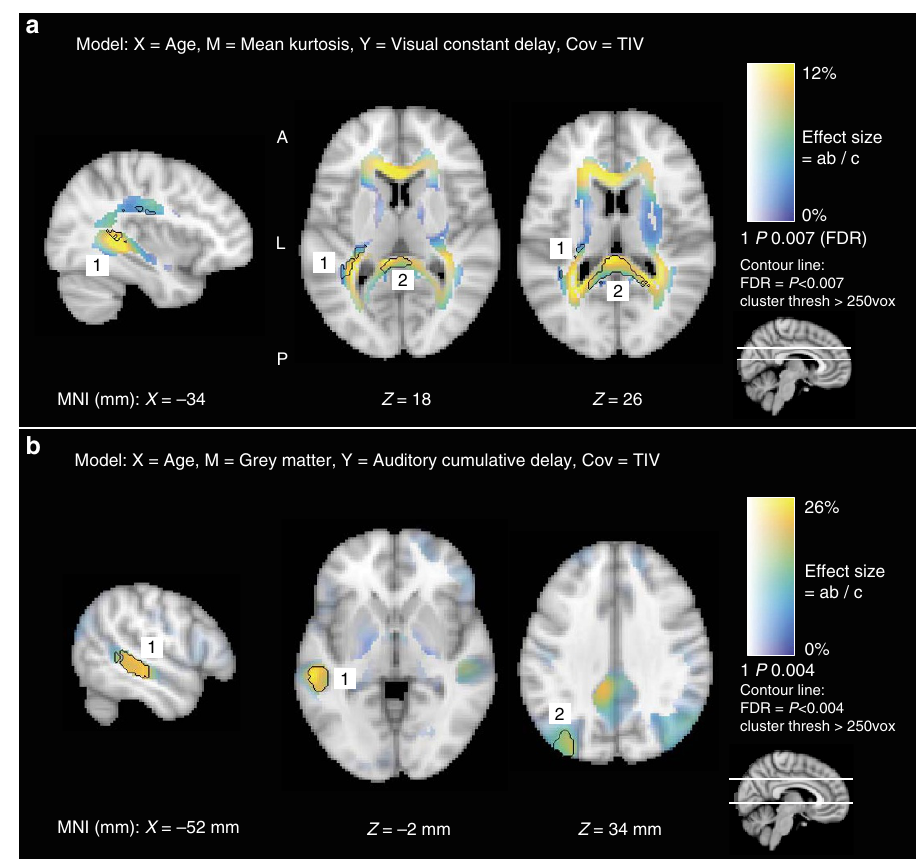
Figure 4 | Whole-brain voxel-wise mediation analysis results. Voxel hue corresponds to the effect size (% mediation effect), while opacity corresponds to the univariate P value. Clusters of at least 250 voxels that survive FDR correction are marked with a black border. ( a ) WM structure (MK) in the optic radiation (connecting LGN to V1) [label 1], and in splenium of corpus callosum [label 2], mediates the age versus visual constant delay relationship. ( b ) GM volume in the left posterior STG mediates the age versus auditory cumulative delay relationship [label 1]. Another cluster was observed in the left superior lateral occipital cortex, a region not involved in auditory processing [label 2]. All effects indicate positive mediation (that is, the age versus delay relationship is attenuated when including the